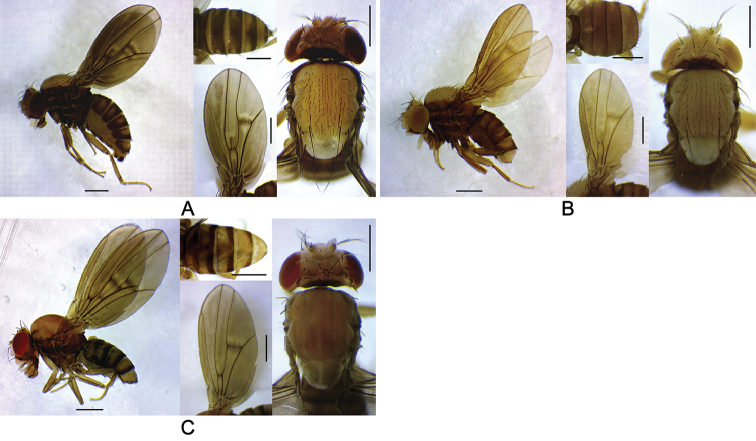
Left lateral habitus, thorax, wing, and abdomen of Dudaica species (part 2). Aqiongzhouensis (holotype #03420) Borthophallata sp. n. (holotype #00177) Cdissimilis (holotype #00430). Scale bars: 0.5 mm.